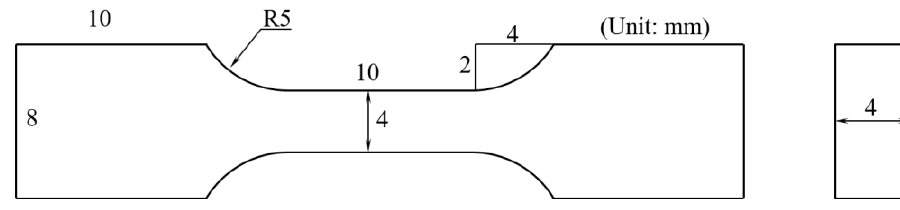
Figure 1. Illustration of the specimen geometry and dimensions. Table 1. Load step and number of specimens per test.